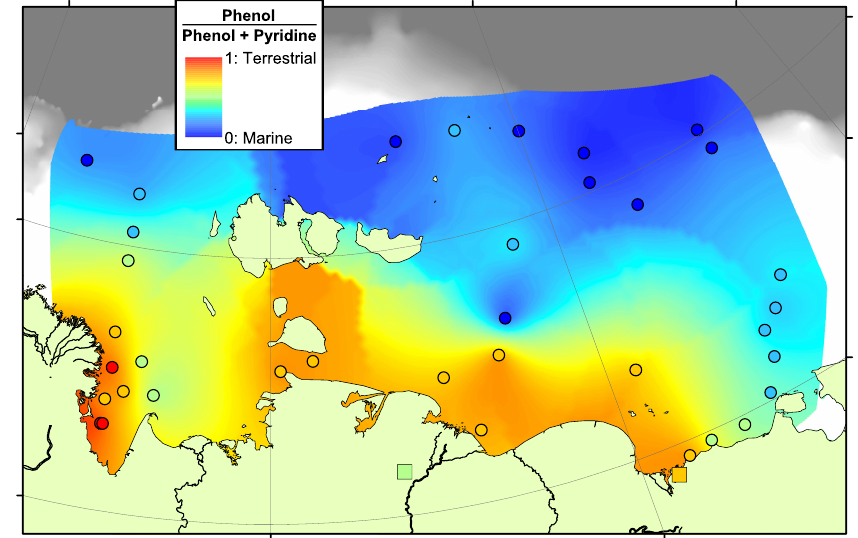
Figure 3. Map of the phenol/pyridine ratio across the ESAS (ratio is calculated from the relative abundances of phenol / (phenol + pyridine); higher values are interpreted as being terrestrial-dominated). Coloured circles show the ratio measured in each offshore sample; squares show onshore ice complex sample values. Interpolation between samples was carried out using a kriging algorithm within the software package